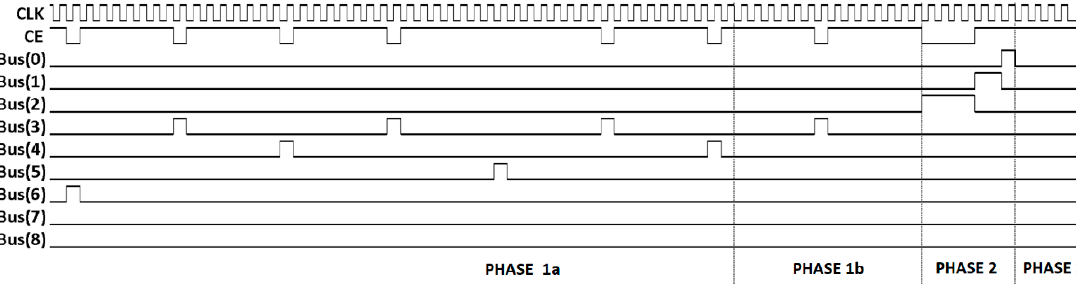
Figure 6. Timing diagram for the Bus(0) ‐ Bus(8) with the gain and offset correction. Only the last part of the waveform has been presented for better clarity. The first waveform shows the pixel clock (for better readability the presented clock frequency is constant in phase 1a). The second waveform shows the pixel clock enable (CE) signal for gain correction coefficient 459/511, offset correction +3, and global offset correction +4.